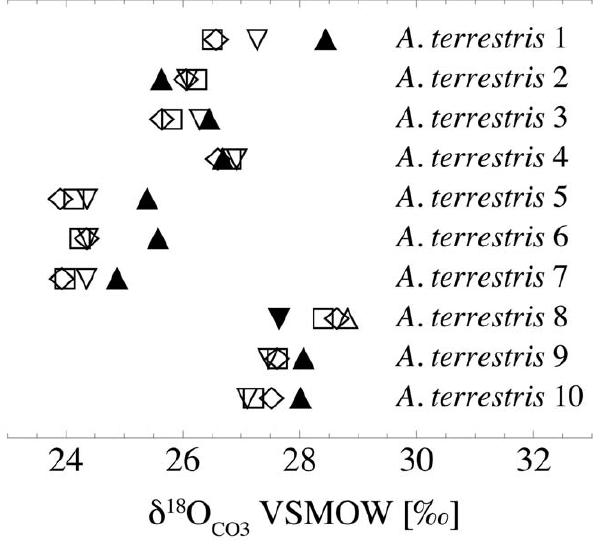
Figure 8. D 18 O CO3-PO4 of incisors, first molars and bone in A . terrestris 1 to 5. Triangles represent the incisors, diamonds the first molars and circles the bones. The average value for all samples is 10.9 6 0.8 % (solid and dashed lines).